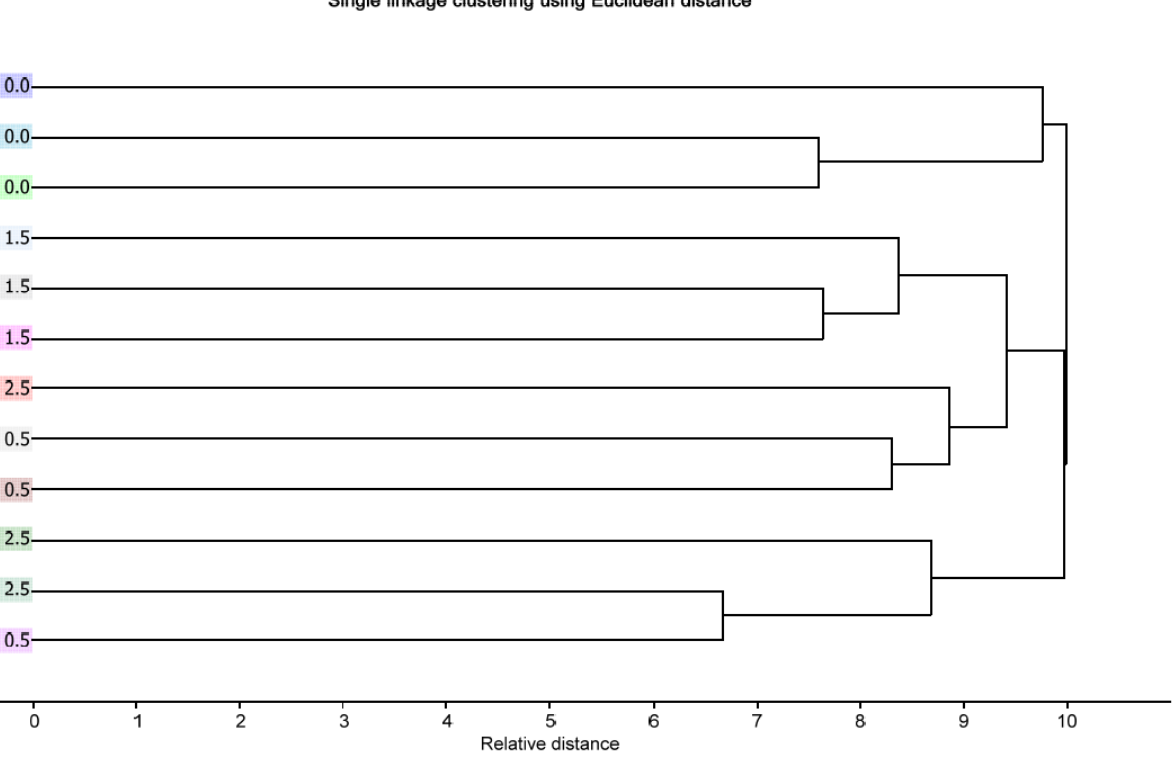
Figure 9. Dendrogram showing the results of the hierarchical cluster analysis performed on the normalised volatile data.